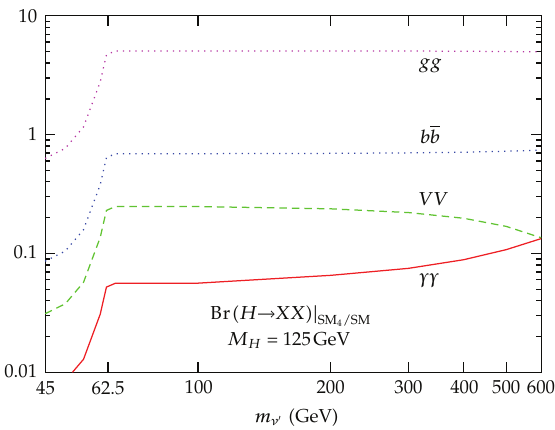
Figure 7: Higgs branching ratios in dependence of the mass of the fourth neutrino for a Higgs mass of 125GeV. Below 𝑚 󸀠 𝜈 = 62.5 GeV the new invisible decay channel 𝐻 → 𝜈 4 𝜈 4 opens and all other branching ratios will be strongly suppressed. This plot was, however, created with an approximate NLO expression for 𝐻 → 𝛾𝛾 . The full expressionwillgiveafurthersuppressionofthetwo-photonchannel by a factor of about six. Figure taken from